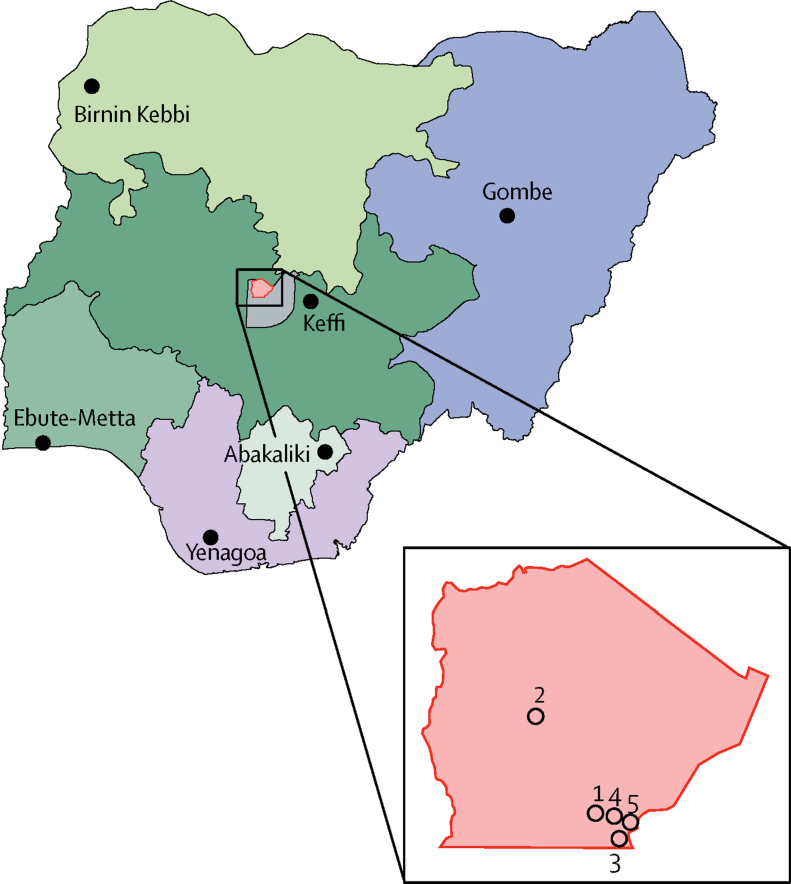
Maps of Nigerian geopolitical zones and locations of study centresMap shows six geopolitical zones in Nigeria and locations (black dots) of Millennium Development Goal sickle cell centres at which high-performance liquid chromatography machines were implemented in 2011–12. The Federal Capital Territory is in the centre of the map and the Gwagwalada Council Area is highlighted in red. Inset map shows locations (open circles) of the five primary health-care centres in the Gwagwalada Council Area that participated in this screening study for sickle cell disease. 1=University of Abuja Teaching Hospital. 2=Dobi Community Clinic. 3=Dagiri Comprehensive Heath Centre. 4=Gwagwalada Township Clinic. 5=Angwan Dodo Public Health Centre.